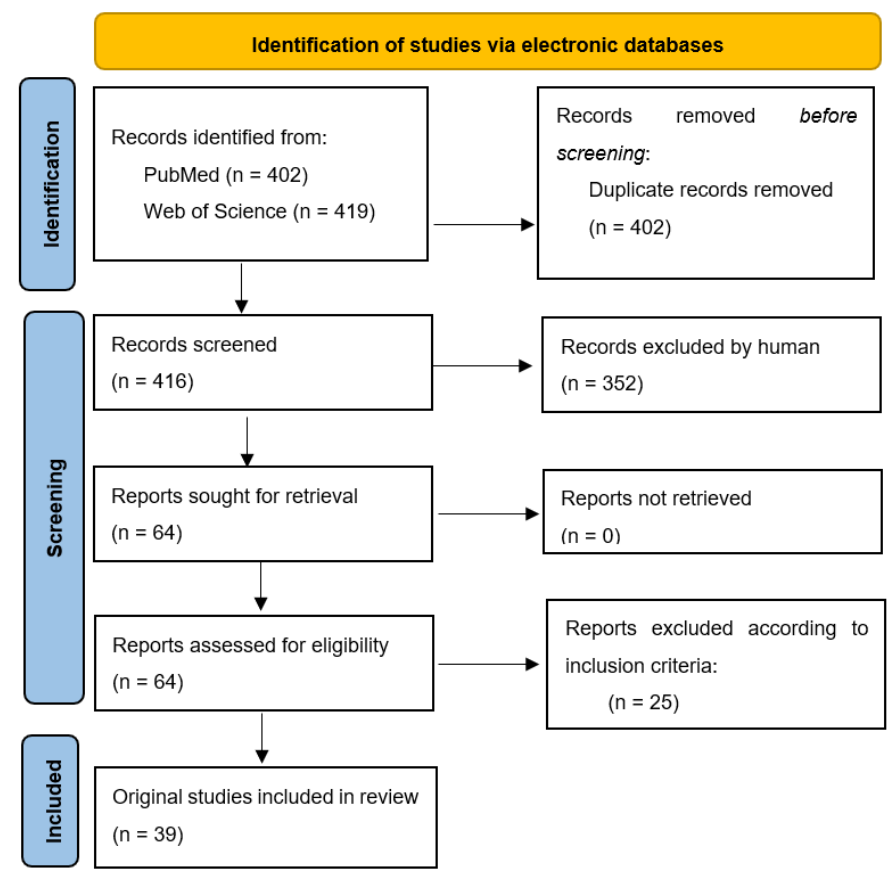
Figure 3. Prisma flow chart for systematic reviews [125].